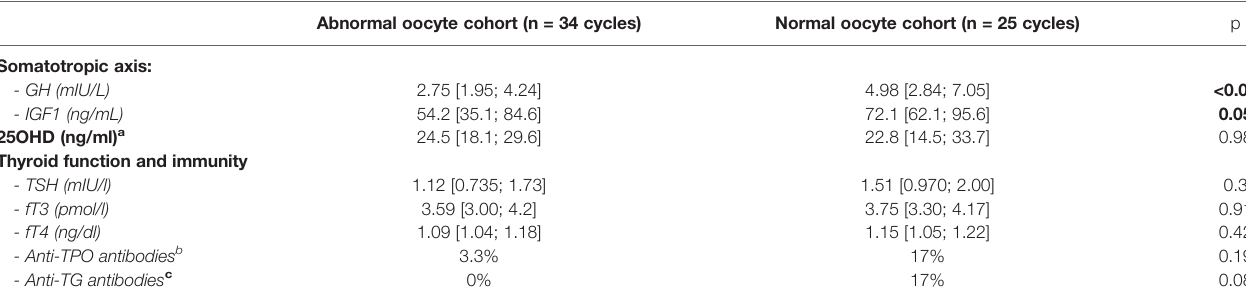
TABLE 3 | Follicular hormone levels and prevalence of antithyroid antibodies in the FF, as a function of oocyte cohort quality. Abnormal oocyte cohort (n = 34 cycles) Normal oocyte cohort (n = 25 cycles) p Somatotropic axis: - GH (mIU/L)